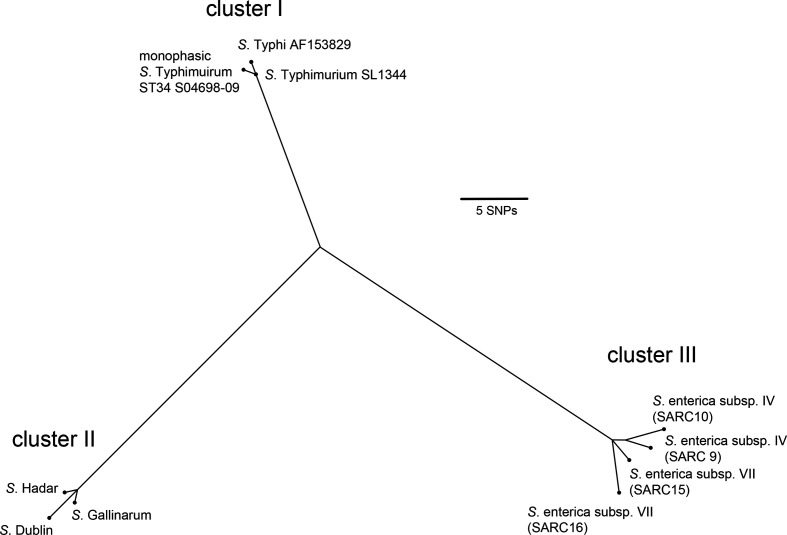
Phylogenetic relatedness of sopE from diverse
S. enterica
 subspecies and
S. enterica
 subsp.
enterica
 serovars. The unrooted ML tree, generated with RAxML based on nucleotide variation, identified three clusters, with cluster I comprising the sopE sequence of monophasic S. Typhimurium ST34 from isolate S04698-09.